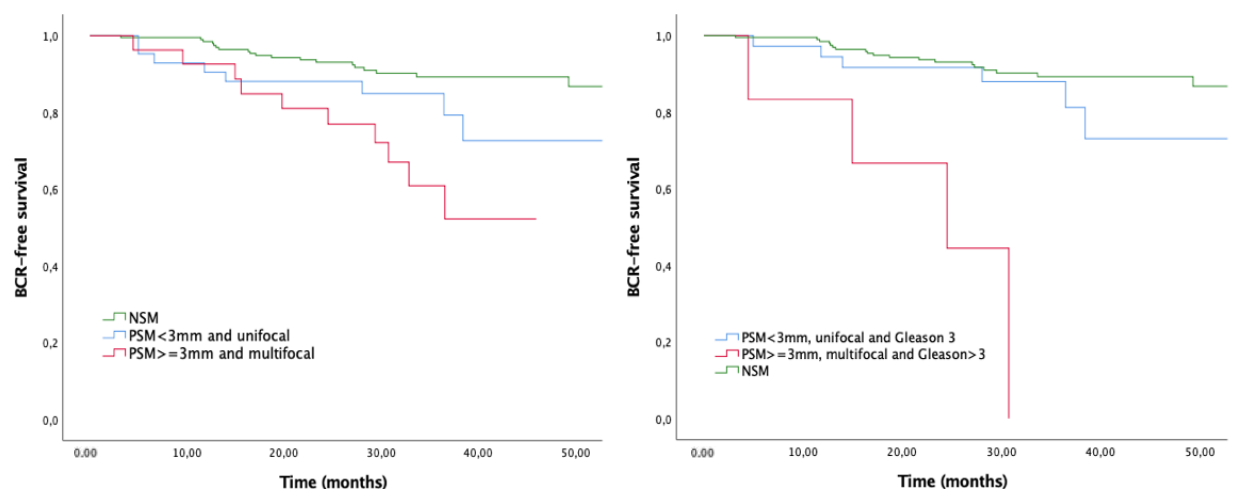
Figure 3. Kaplan–Meier curves for biochemical recurrence stratified by combined adverse margin Figure 3. Kaplan – Meier curves for biochemical recurrence stratified by combined adverse margin characteristics. Log-rank p < 0.001. characteristics. Log-rank p < 0.001.